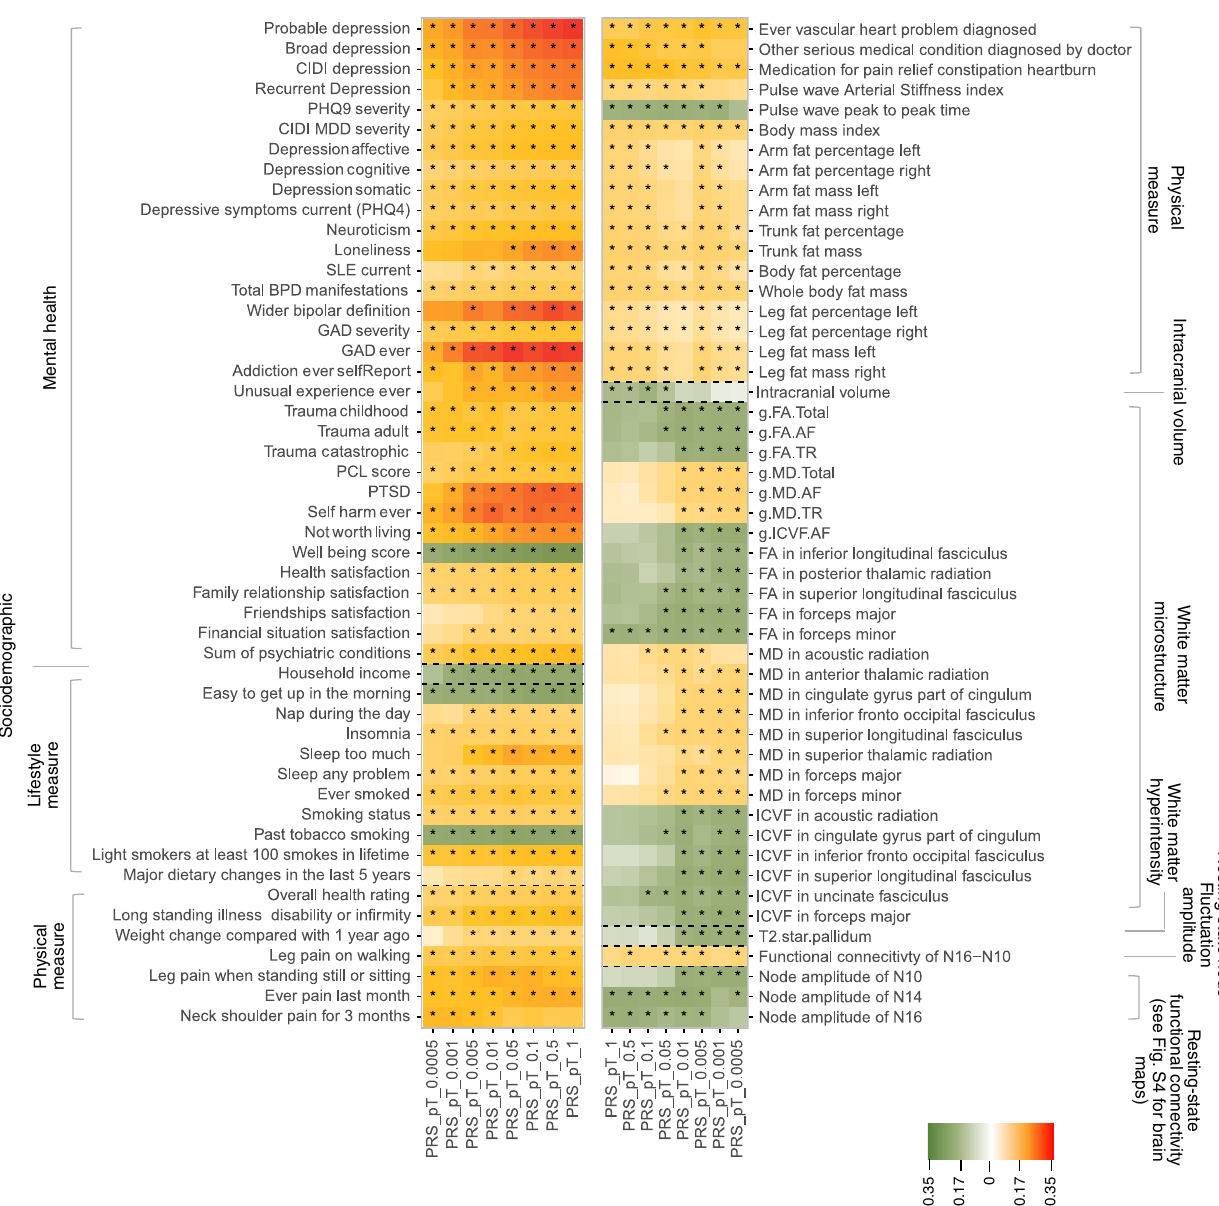
Fig. 2 Heatmap for the traits that were signi fi cantly associated with depression-PRS. The shown traits were signi fi cantly associated with depression-PRS at a minimum of four p thresholds for depression-PRS. Shades of cells indicate the standardised effect sizes ( β ) for the linear regression between depression-PRS and each phenotype. A larger effect size was shown by a darker colour. Cells with an asterisk were signi fi cant after FDR correction. Descriptions for the variables in detail can be found in Table 1, Supplementary Table 1 and Supplementary Data